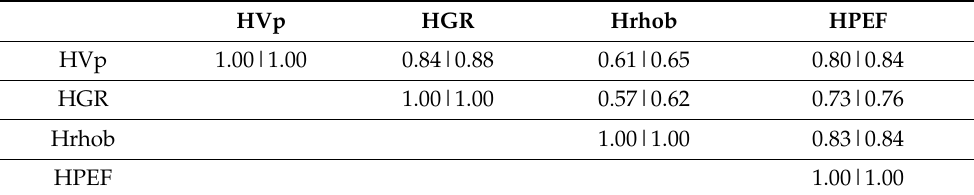
Figure 6. Regularity profiles obtained from the physical measurements of Figure 5. Dashed lines: layer boundaries (in green), limestone beds (in black), and shale beds (in magenta) (the layer boundaries in dashed lines are taken from [35]). The H logs are computed using the algorithm detailed in Section 2.3, from the raw data (in red) and data processed by the GST (in blue). Note that the local extrema of the H logs correspond to the lithological discontinuities. It can be noted that on the regularity profiles derived from the “porosi- ty-dependent” logs, almost all the lithological discontinuities, which are either layer boundaries or thin rock beds occurring within the studied depth intervals, are marked by jumps in H value. Table 1. Correlation coefficients between the regularity profiles derived from the analyzed well logs (without GST | with GST). HVp